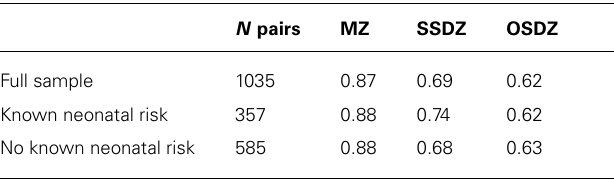
Table 1 |Twin probandwise concordances on object attachment by